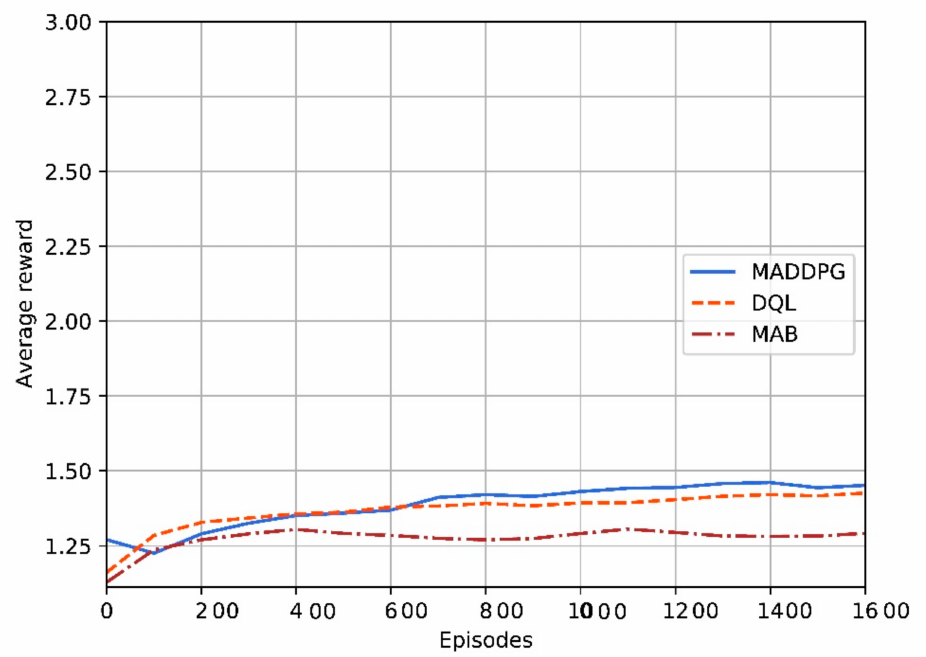
Figure 10. Convergence behavior for the reinforcement learning